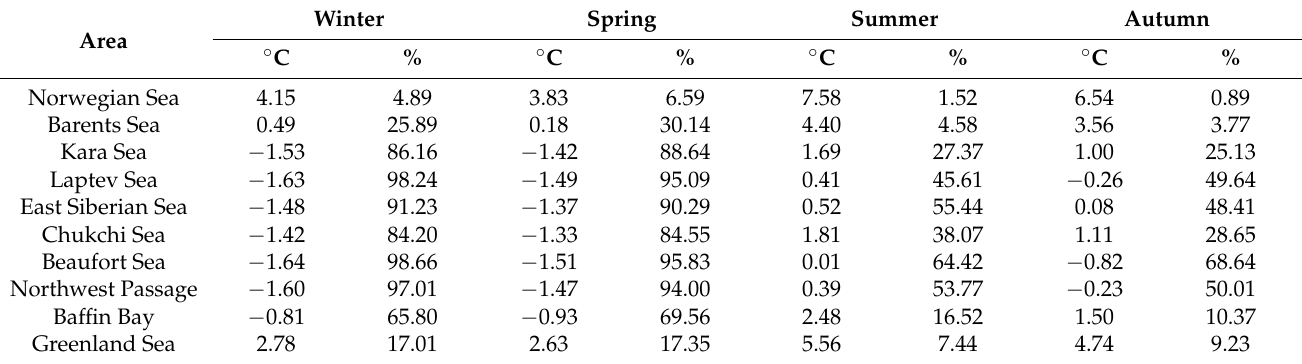
Table 2. Seasonal average SST ( ◦ C) and SIC (%) in typical sea areas of the Arctic, 2002–2021.